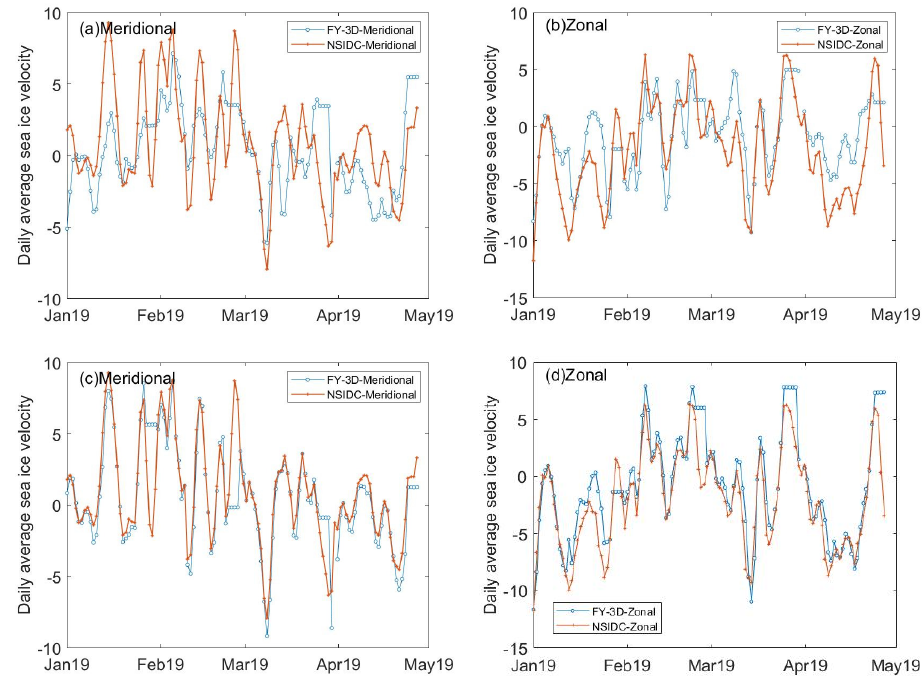
Figure 14. Comparisons of daily average velocities. ( a ) and ( b ) are the comparisons of the sea ice motion obtained from the NSDIC product and retrieved from FY ‐ 3D/MWRI T b data (combining the different polarizations and frequencies) in the meridional and zonal direction, respectively. ( c ) and ( d ) are the comparisons of sea ice motion obtained from the NSIDC product and retrieved from FY ‐ 3D/MWRI T b data with data assimilation in the meridional and zonal direction, respectively.